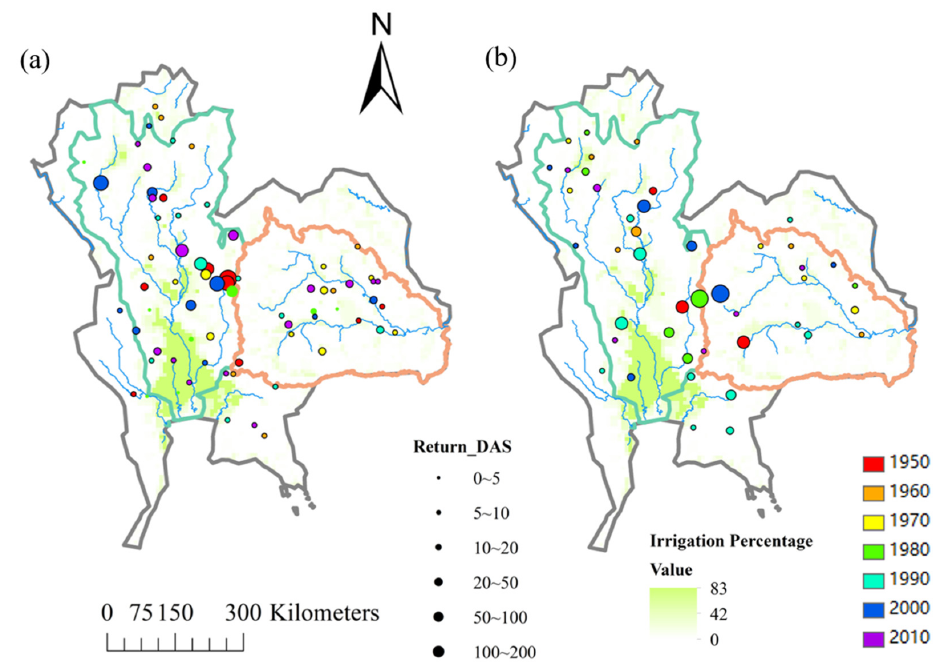
Figure 4. The spatial distribution of historical droughts over the past 67 years. The spatiotemporal distribution of historical droughts. Droughts are drawn at their center, and droughts with larger circles have longer trivariate return periods. The year 1950 refers to the period 1948–1954, 1960 refers to the period 1955–1964, and 1970 refers to the period 1965–1974, et cetera. ( a ) and ( b ) show the spatiotemporal distributions of the centers of meteorological droughts and soil droughts, respectively. The region inside the green line is the Chao Phraya River basin, while the region inside the orange line is the Mun River basin.